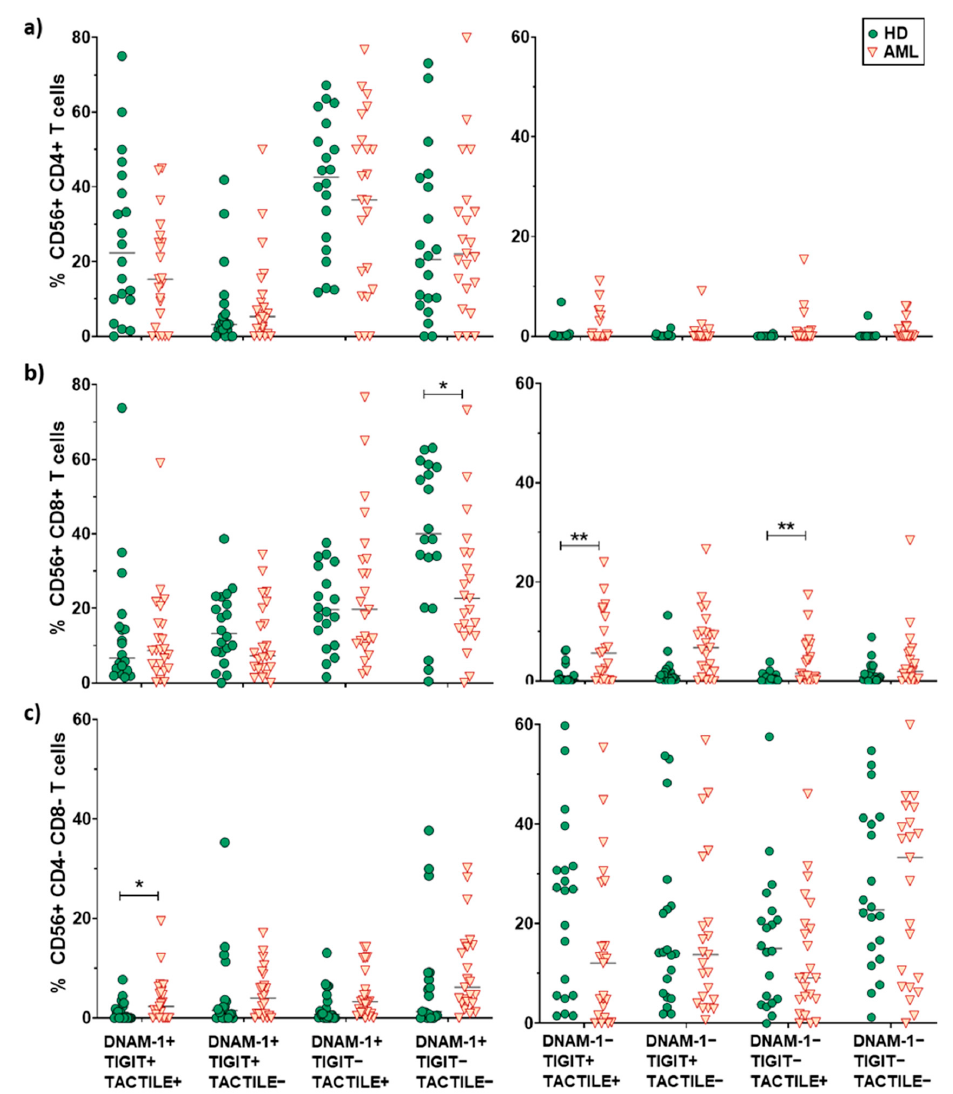
Figure 7. Analysis of DNAM-1, TIGIT and TACTILE co-expression in CD56+ T cell subsets. Eight different subpopulations can be observed according to the co-expression of DNAM-1, TIGIT and TACTILE. The distribution of these subsets in CD4+ T cells ( a ), CD8+ T cells ( b ) and CD4 − CD8 − T cells ( c ) in HD ( n = 20) and AML patients ( n = 23) is shown. The median values are indicated by a horizontal black line. Results were considered significant at * p < 0.05 and ** p < 0.01.